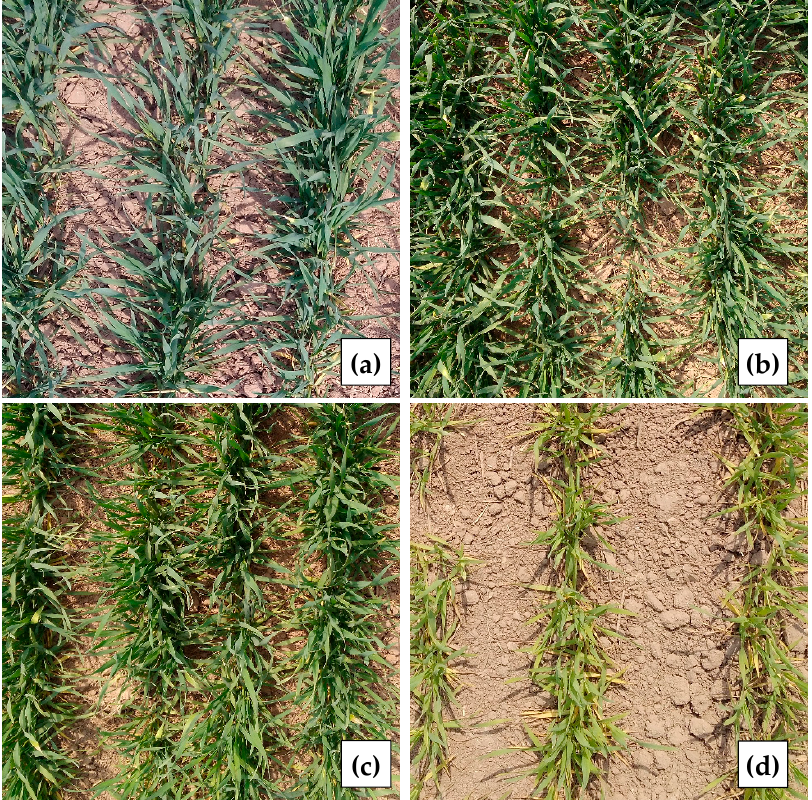
Figure 3. Winter wheat canopy photos. ( a – d ) Are from the plots with N3, N2, N1, and N0, respectively.